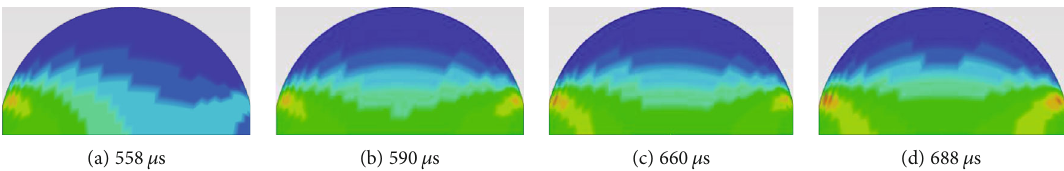
Figure 8: Stress distribution in FBD specimens at di ff erent